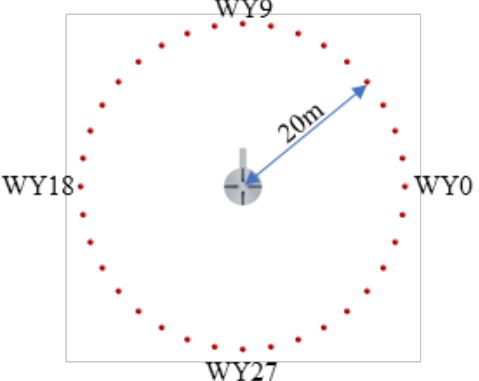
Figure 20. Position of monitoring points at stern rudder section.